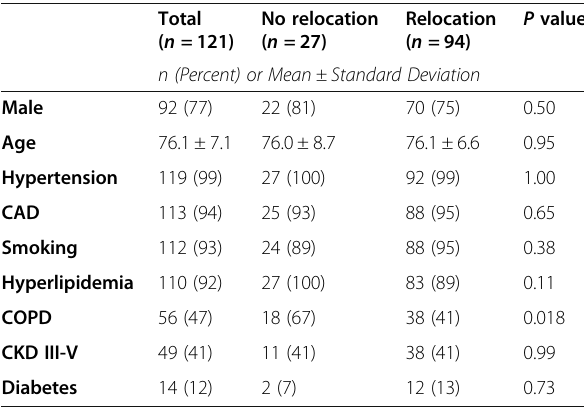
CAD Coronary artery disease, CKD Chronic kidney disease, COPD Chronic obstruction pulmonary